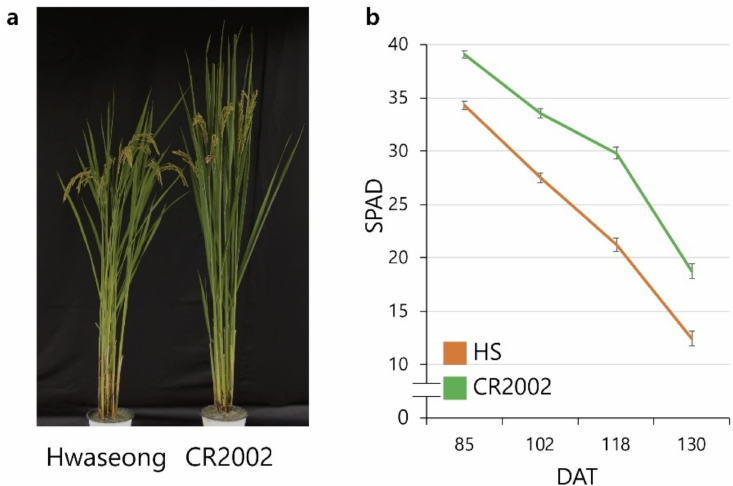
Figure 1. CR2002 showed a higher SPAD value and delayed senescence than Hwaseong in the field condition. Comparison of ( a ) plant morphology and ( b ) SPAD value ( n = 30) of two parents. Error bars indicate the standard error. DAT: days after transplanting. Table 1. Comparison of agronomic traits and chlorophyll content between Hwaseong and CR2002. Trait Hwaseong